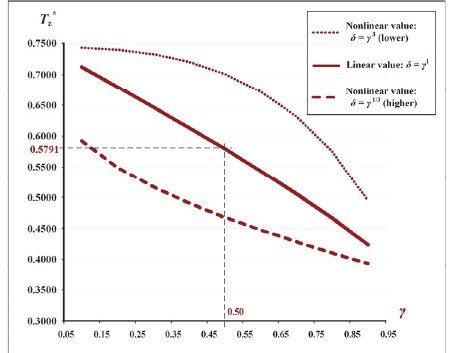
Fig. 14. The impact of the linear/nonlinear relationships between  and  on T Z